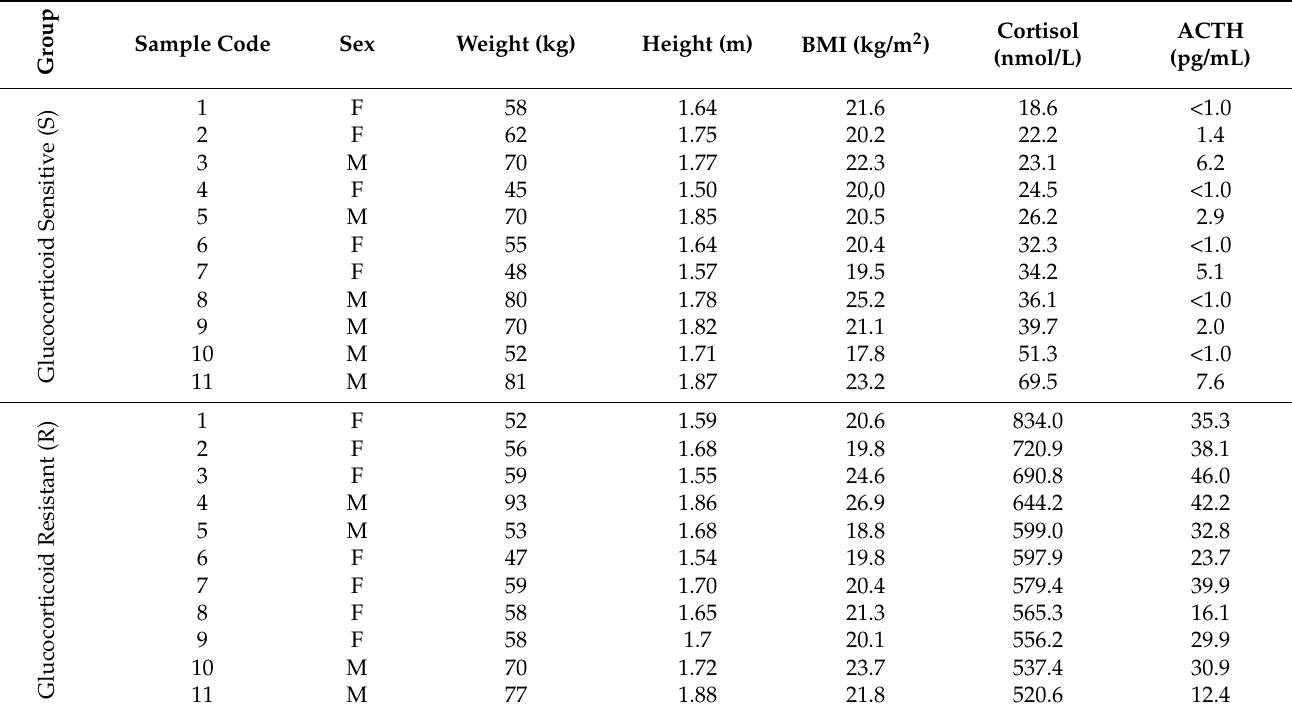
Table 1. Clinical characteristics, and serum cortisol and plasma ACTH concentrations of the most glucocorticoid sensitive (S) and most glucocorticoid resistant (R) healthy subjects at the time of the very-low dexamethasone suppression